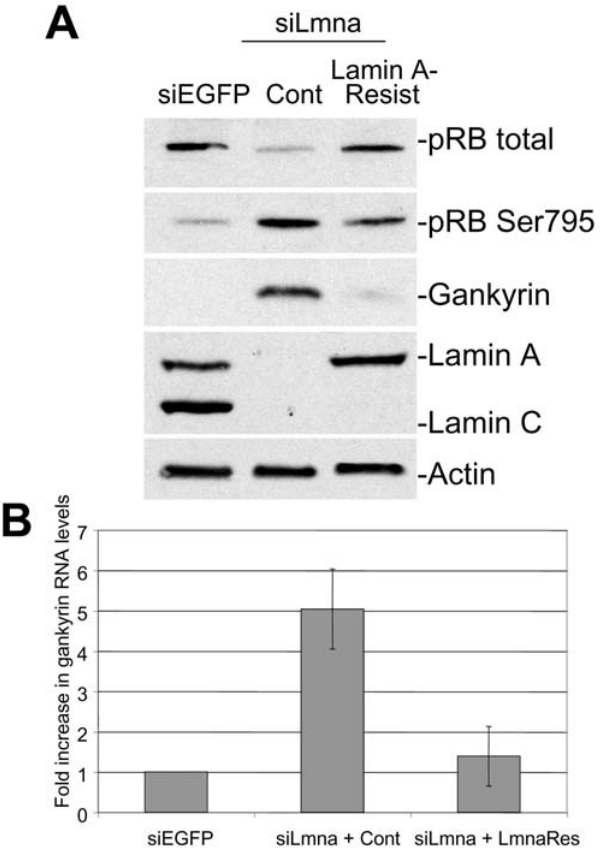
Figure 2. Reintroduction of human lamin A restores pRB and gankyrin expression. NIH3T3 siLmna cells were stably transduced with human lamin A (lamin A-res) that was designed to contain several silent codon changes at the target site of the siRNA, thereby rendering it resistant to the siRNA. (A) Western analysis comparing gankyrin and pRB protein levels in siLmna expressing lamin A-res (siLmna-lamin A resist) to siLmna infected with the control vector (siLmna-Cont). (B) QPCR analysis comparing the relative mRNA’s of gankyrin in siLmna- lamin A resist cells to siLmna-Cont cells. Data represent averages of triplicate experiments performed and mRNAs were normalized against Gapdh .